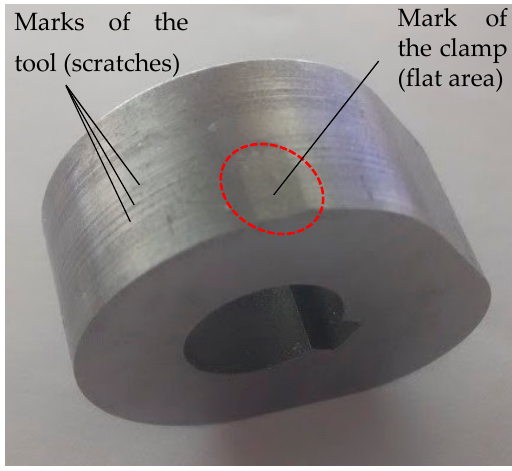
Figure 10. Picture of the cam surface with a flat mark and slight scratches.